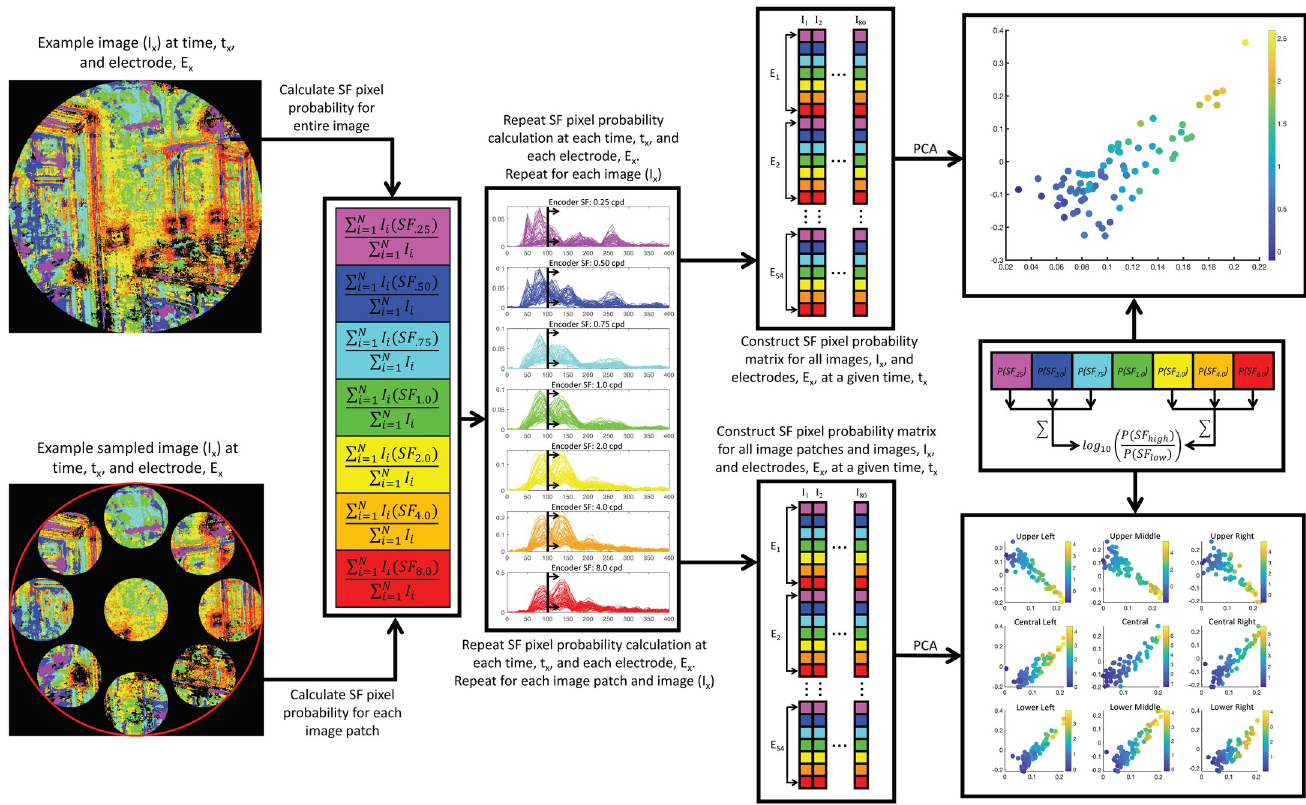
Fig 9. Illustration of the procedure for projecting all encoder-tagged images into a state-space representation at each time point for each participant using all electrodes. This procedure was either carried out for entire images (top left) or within patches located at nine different regions of the images (bottom left). Encoder probabilities were calculated as described in the text for whole images or image patches. At each time point and across all electrodes, each encoder’s probability was stored in a matrix as an array on an image-by-image basis (e.g., a 378 x 80 matrix for each time point). Each matrix was then submitted to PCA, with the first two PCs defining the encoded image’s state-space. Each image was then characterized by taking the log 10 HSF-to-LSF probability ratio (see text for further detail).